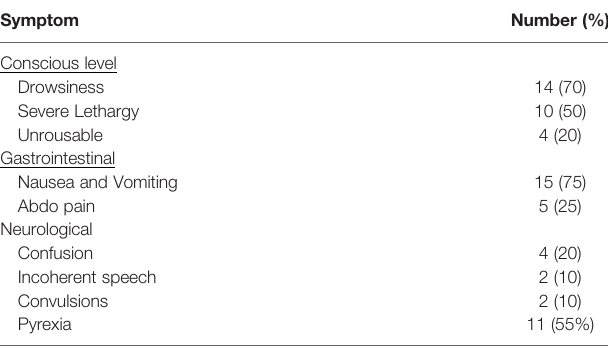
TABLE 3 | Symptoms of patients presenting to hospital with adrenal crisis.